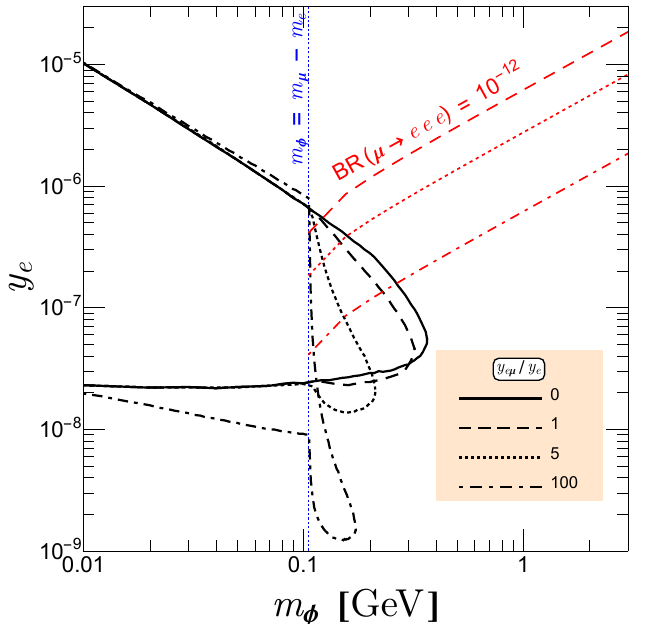
Figure 10 . Presumed exclusion region to φ → ee, eµ, µµ decays in the E137 experiment for the scalar interaction. The parameters are taken as y eµ /y e = 0 (solid), 1 (dashed), 5 (dotted), and 100